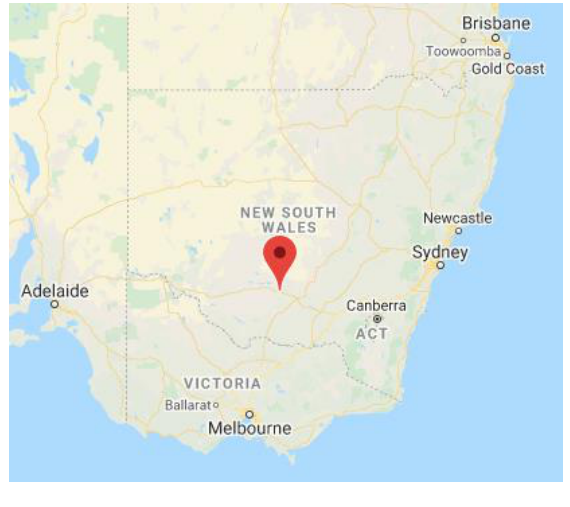
Figure 3: Location map of study area